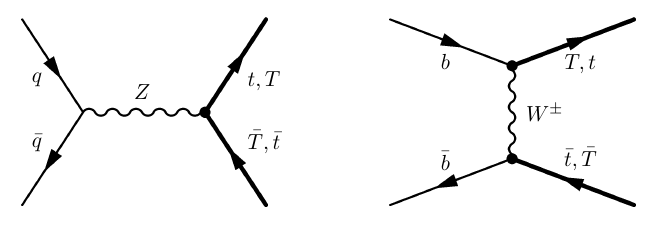
Figure 1 . Leading-order Feynman diagrams for the single T production in association with the top quark at proton-proton collisions: q (cid:22) q ! T (cid:22) t + (cid:22) Tt , where q ((cid:22) q ) runs over all the massless quarks